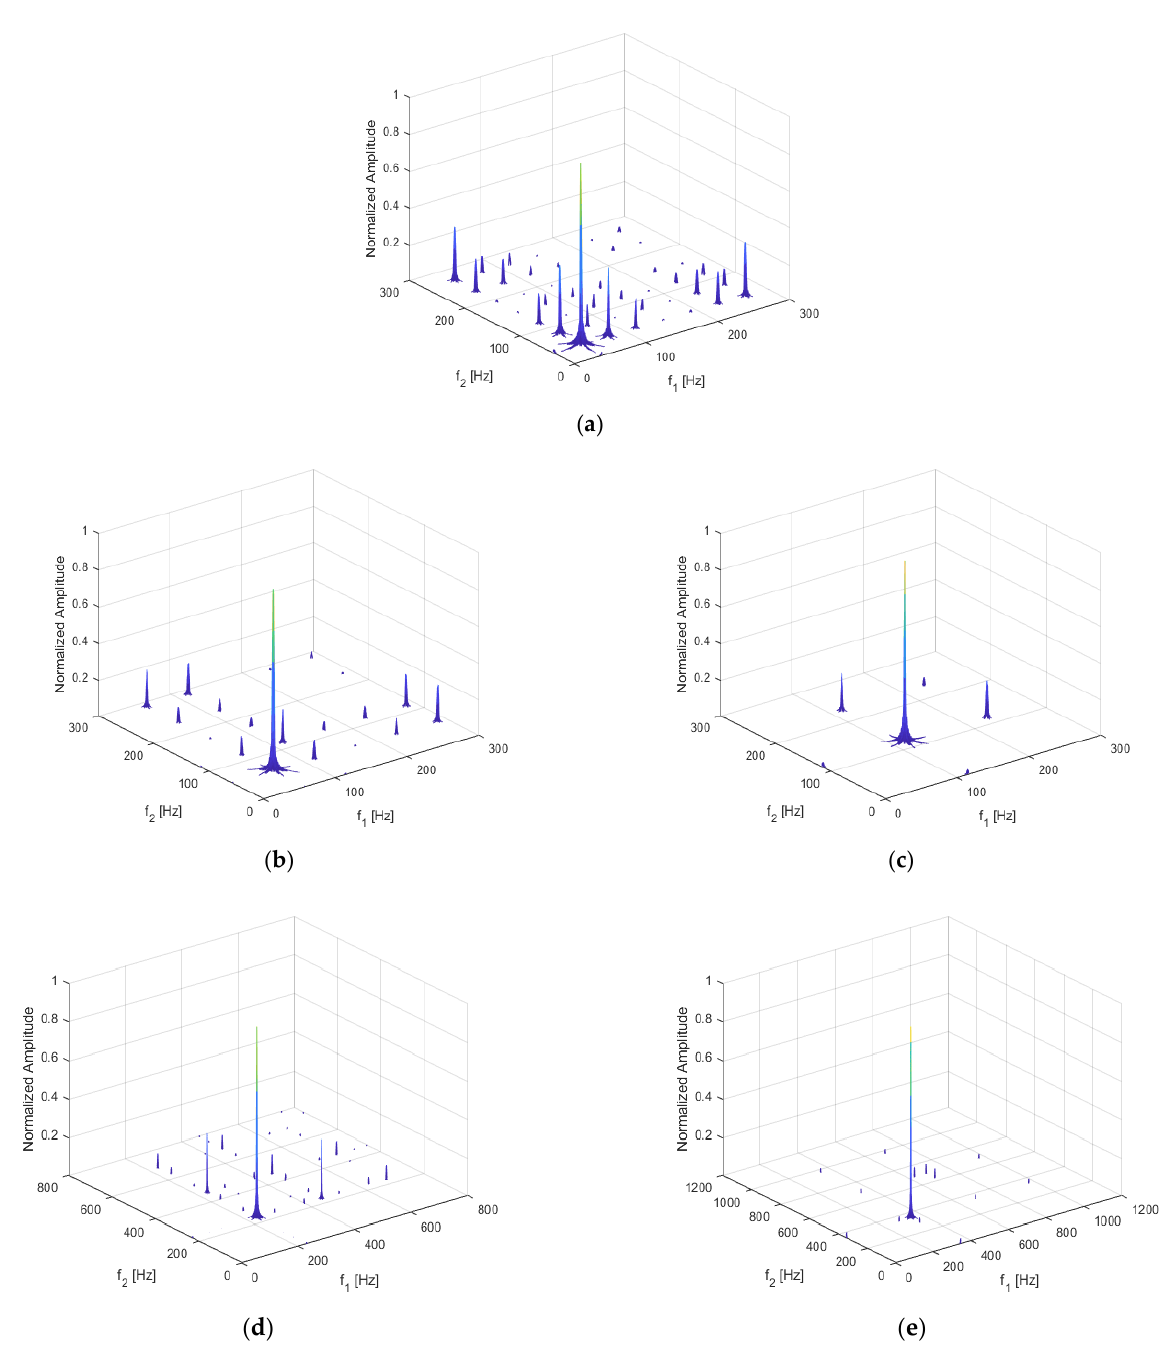
f 1 ; ( b ) ω = 1 f 1 ; ( c ) ω = f 1 ; ( d ) ω = 2 f 1 ; ( e ) ω = 3 f 1 3 2